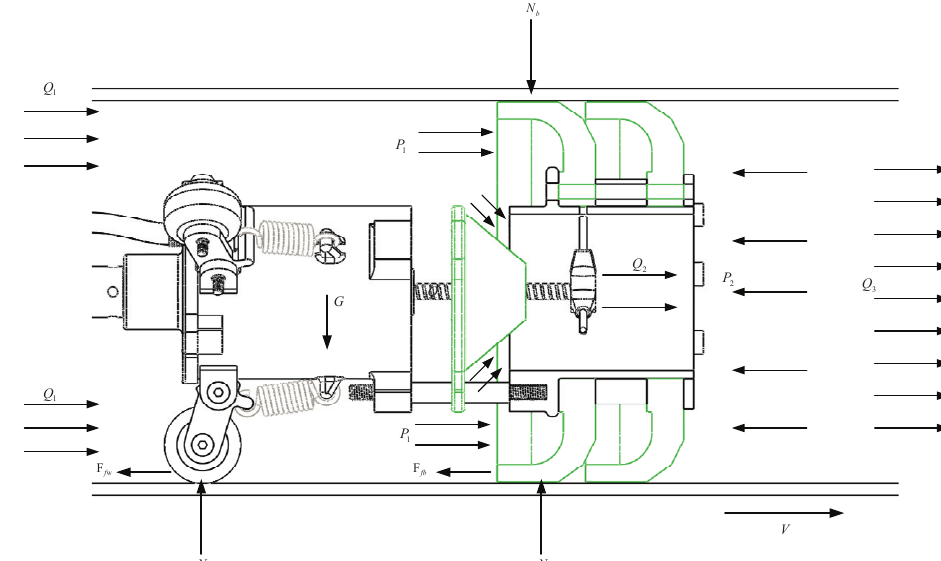
Figure 2. Analysis of the force for traction and the speed regulation